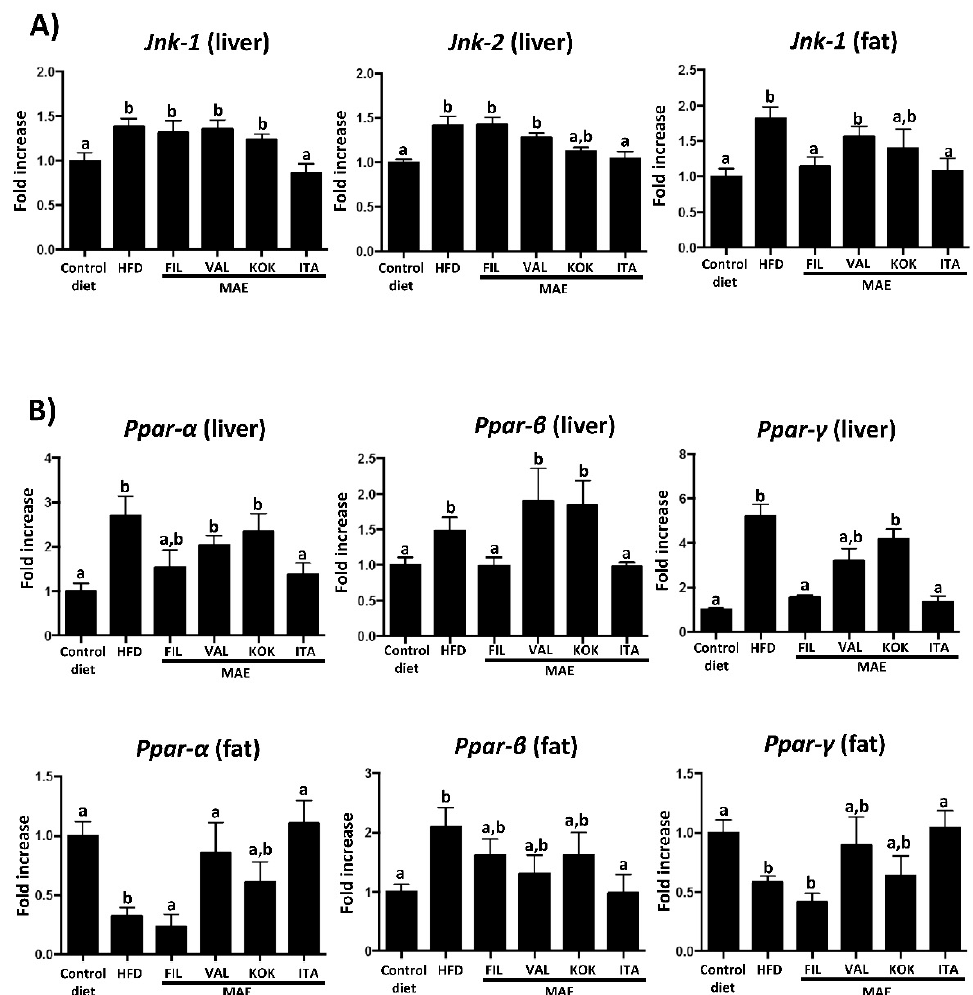
Figure 6. Effects after administration of Morus alba extracts ( genotypes Filipina , Valenciana temprana , Kokuso , and Italia ) in high fat diet (HFD)-fed mice: ( A ) gene expression of Jnk-1 and Jnk-2 ; ( B ) gene expression of Ppar- α , Ppar- β , and Ppar- γ , analyzed by real time qPCR. Data are expressed as means ± SEM ( n = 10). Groups with different letters statistically differ ( p < 0.05).